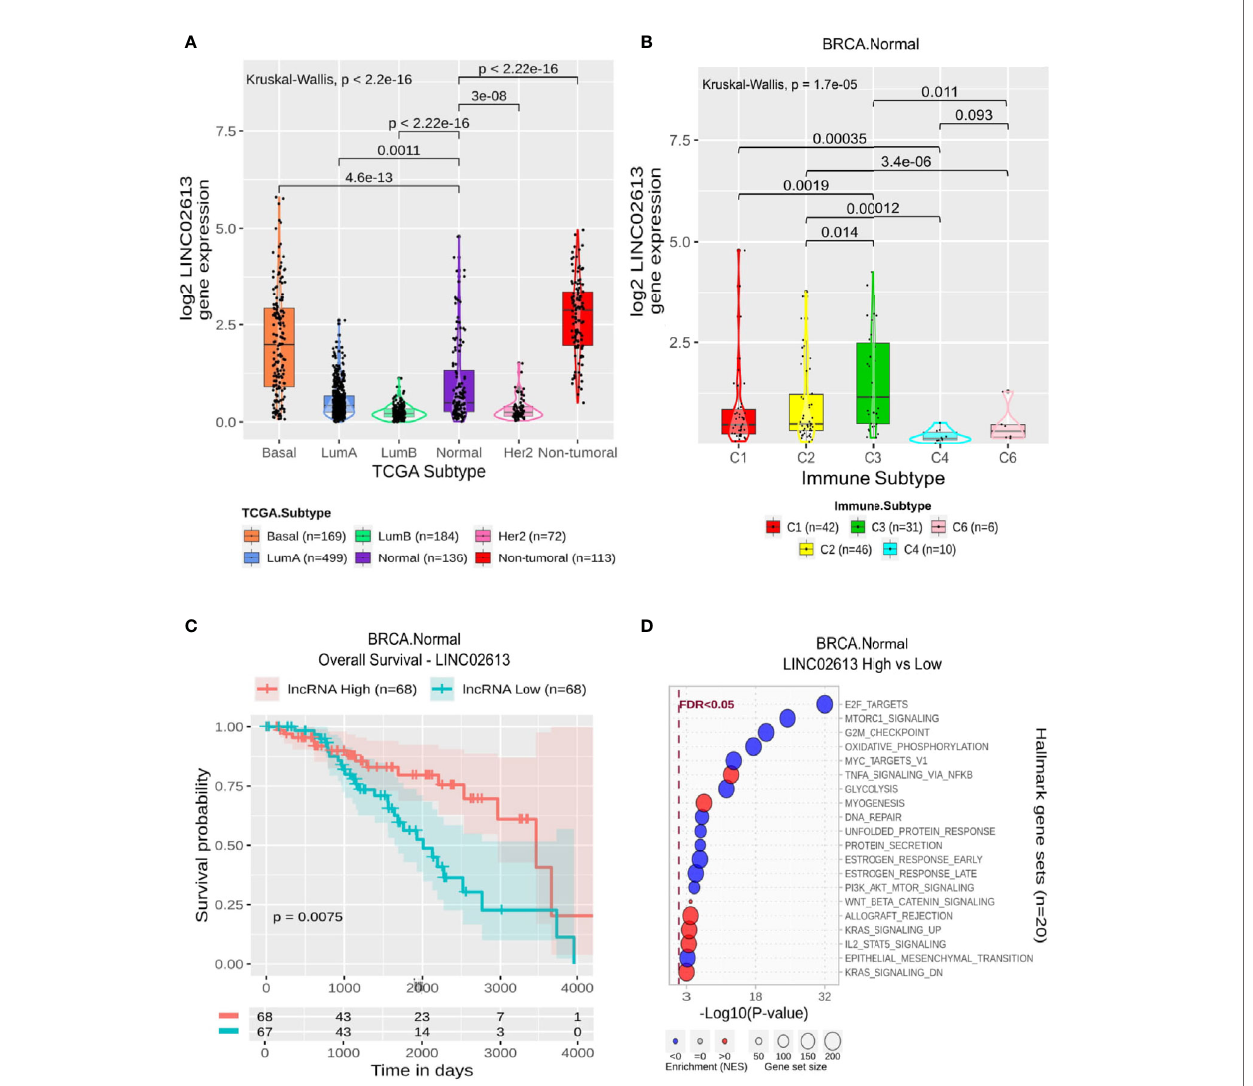
FIGURE 5 | LINC02613 panel representation in normal-like subtype. (A) Box-plots representing LINC02613 expression among all breast cancer molecular subtypes. The Kruskal-Wallis test (p-value represented in the panel left top position) was used to differentiate expression between groups, followed by the Wilcoxon test (p-values represented emphasizing comparisons between subtypes). (B) Box-plot representing LINC02613 in C1,C2, C3, C4 and C6 immune subtypes in normal-like patients. (C) LINC02613 overall survival curves. To de fi ne the two groups, LINC02613 ’ s median expression classi fi ed the patients into “ high ” and “ low ” groups. Logrank p-value represented as 0.0075. (D) Enrichment analysis using Hallmarks gene sets. Red circles refers to activation while blue circles to inactivation. In the X axis, a p-value scale is represented. The circle size varies according to the number genes in of the identi fi ed gene